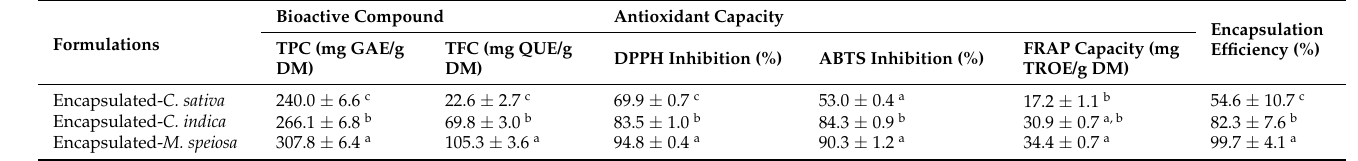
Table 2. Bioactive and antioxidative values, as well as the encapsulation efficiency of chitosan- encapsulated compounds obtained from three plant leaves using the spray-drying technique.